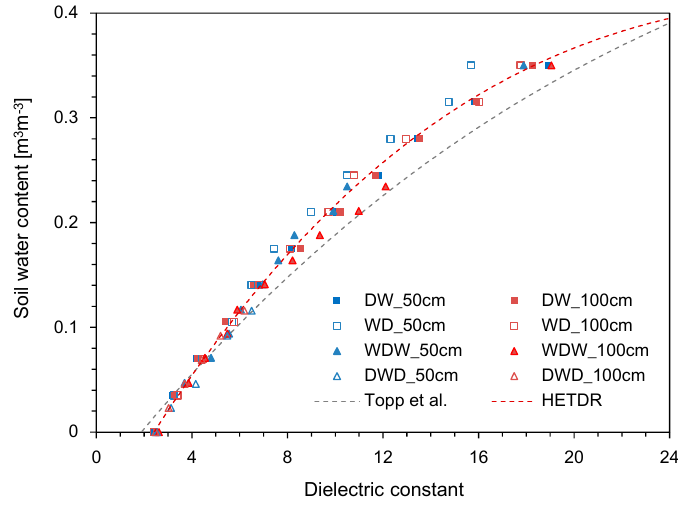
Figure 15. Relationship between the dielectric constant and the SWC.